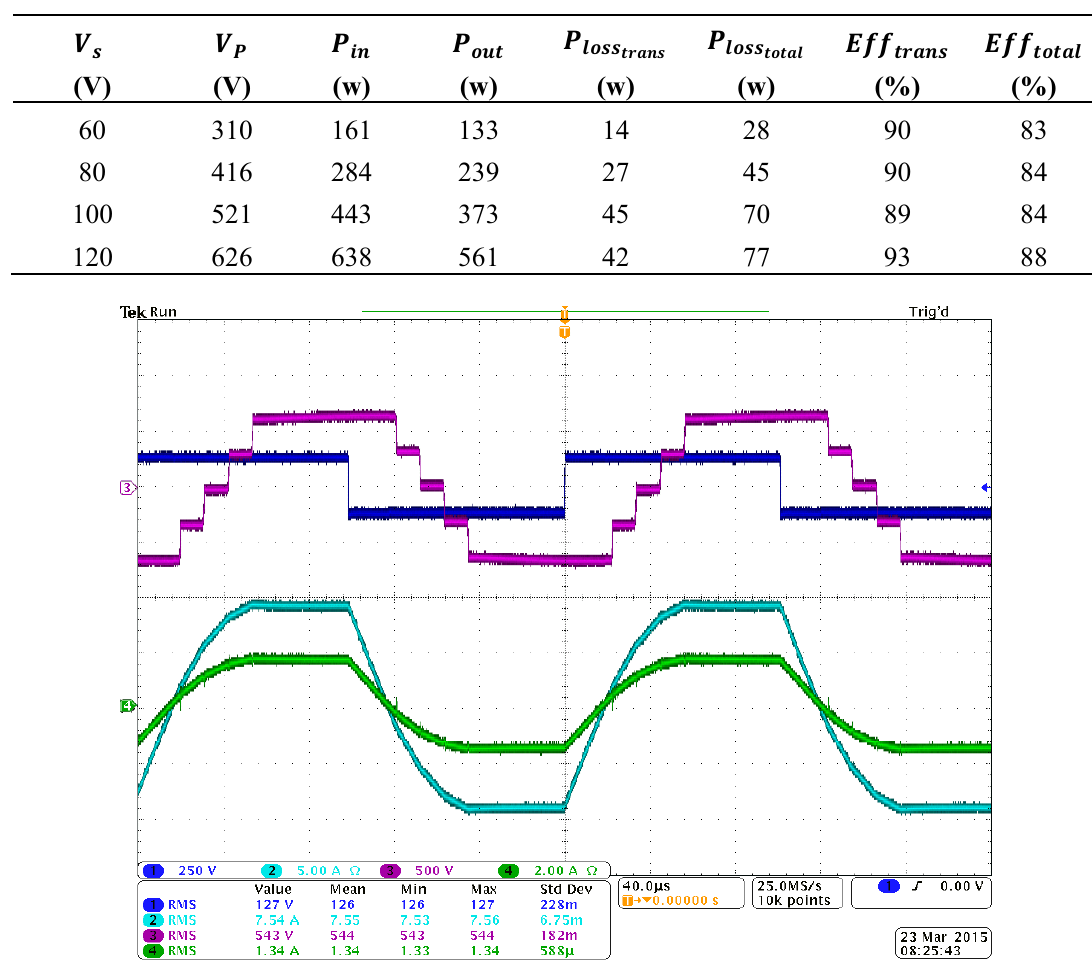
Figure 22. ML-DAB 2L voltage (cid:1874) 5L side of the transformers (cid:1861) (cid:2010) = 30 (cid:2868) and (cid:2038) = 70 (cid:2868)